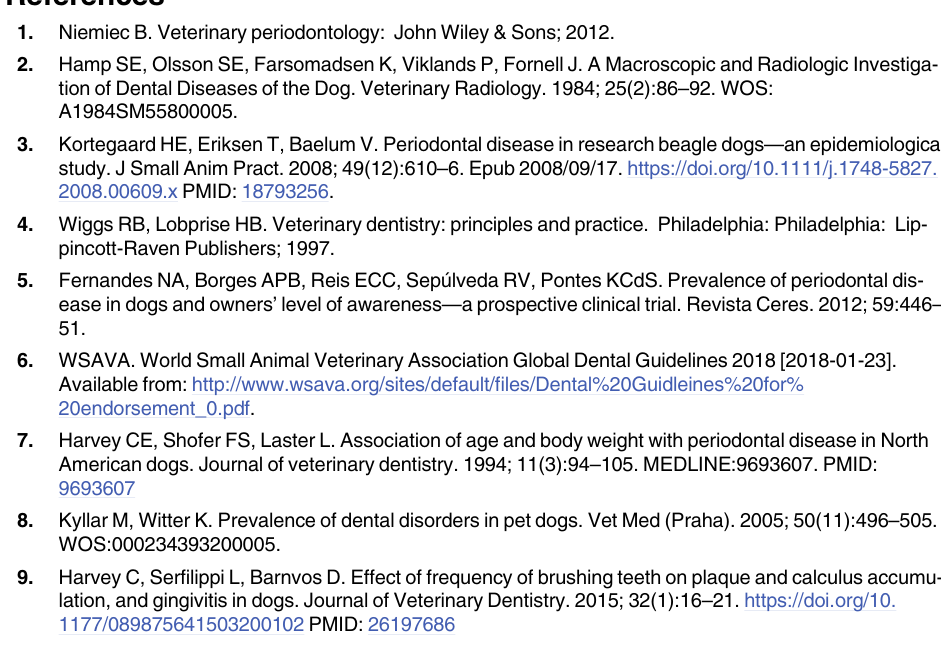
S2 Table. File containing factor analysis